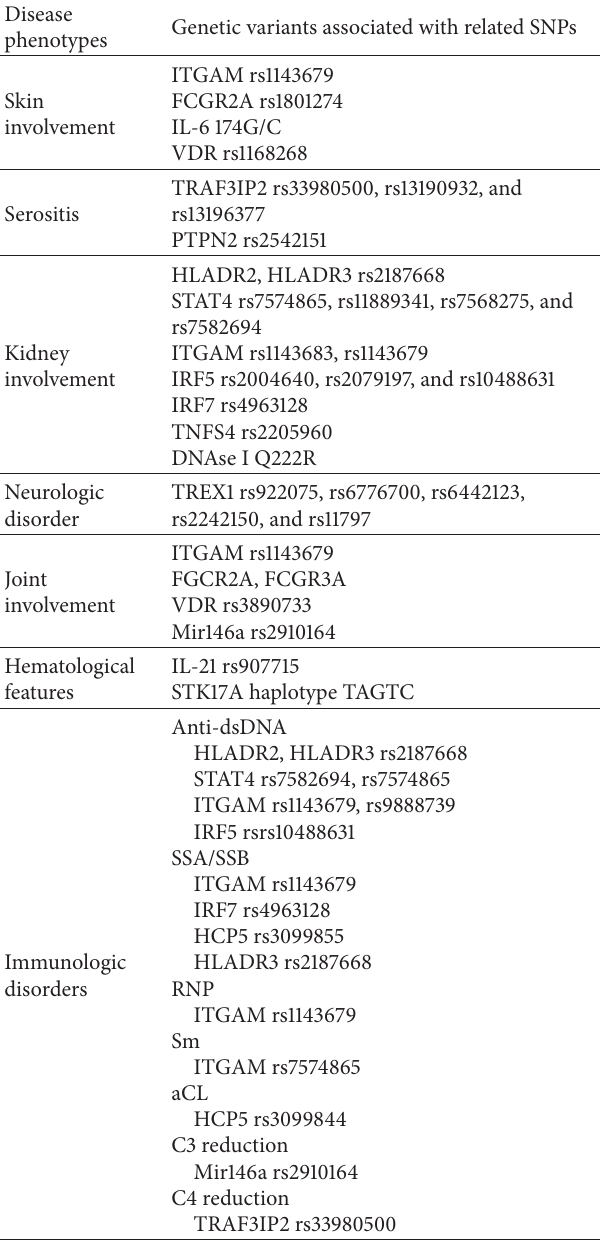
Table 1: Genetic variants associated with disease manifestations.